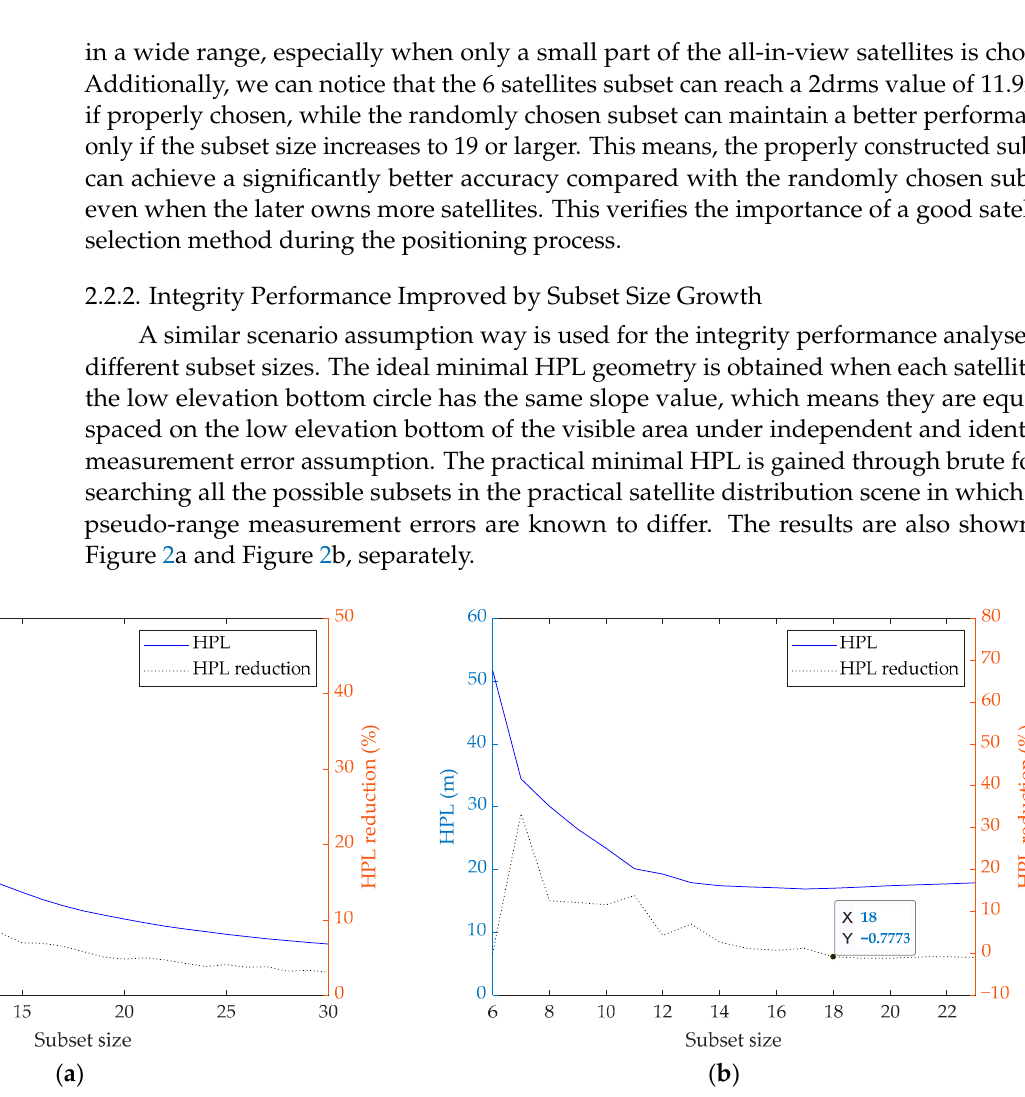
Figure 1. ( a ) Minimal 2drms value and 2drms reduction to the former for each size subset in the ideal scene; ( b ) Accuracy variation range for each size subset in the practical scene.